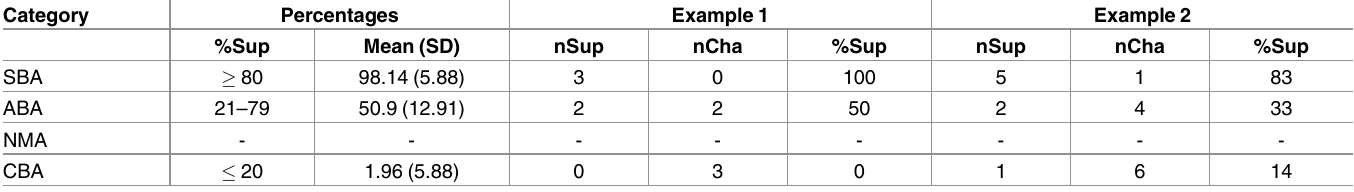
Table 1. Study categorization criteria, examples, and descriptive statistics for each paper category regarding the percentage of behavioral infor- mation supporting the BA.